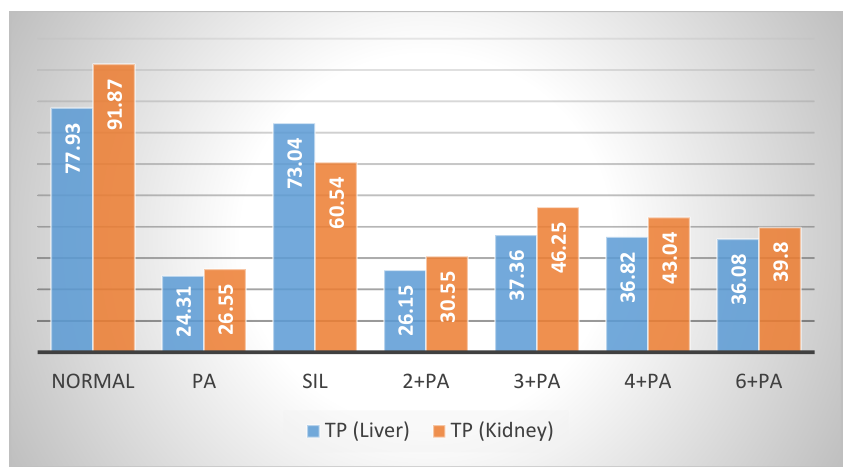
Figure 3. Effect of compounds 2–4 , 6 on liver ( A ) and kidney ( B ) TP.